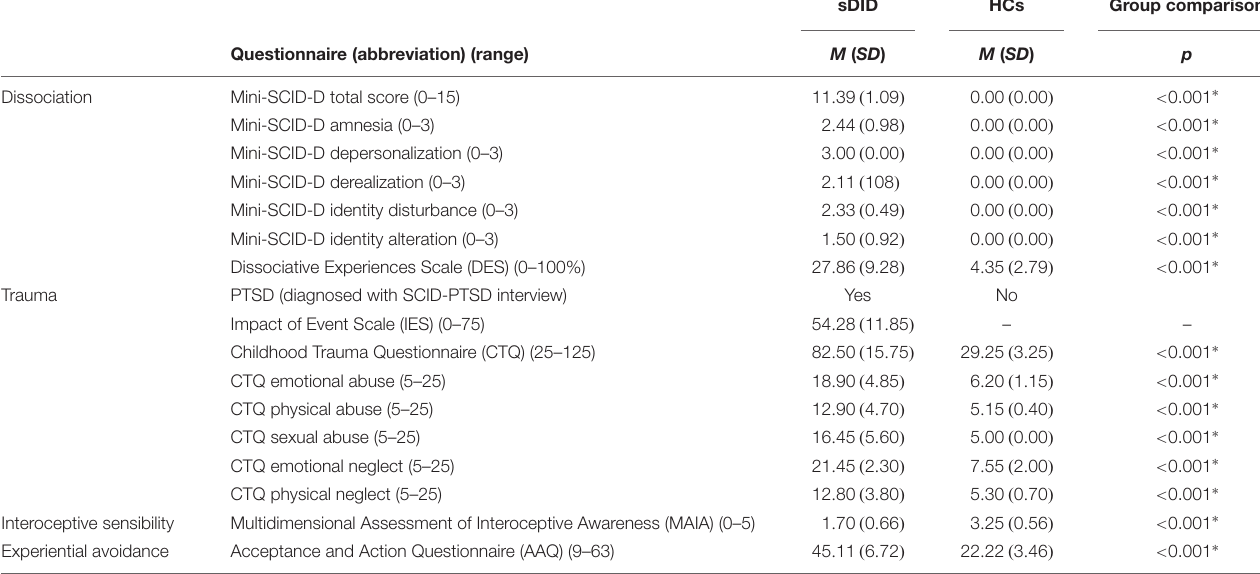
TABLE 2 | Psychometric data.